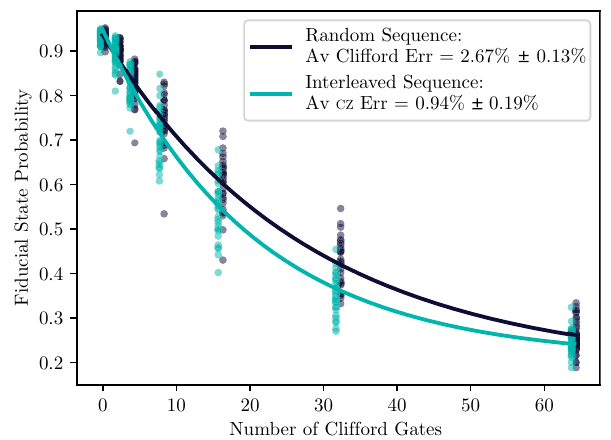
FIG. 12. An example of the interleaved randomized bench- marking data used to produce the fidelities in Tables II and